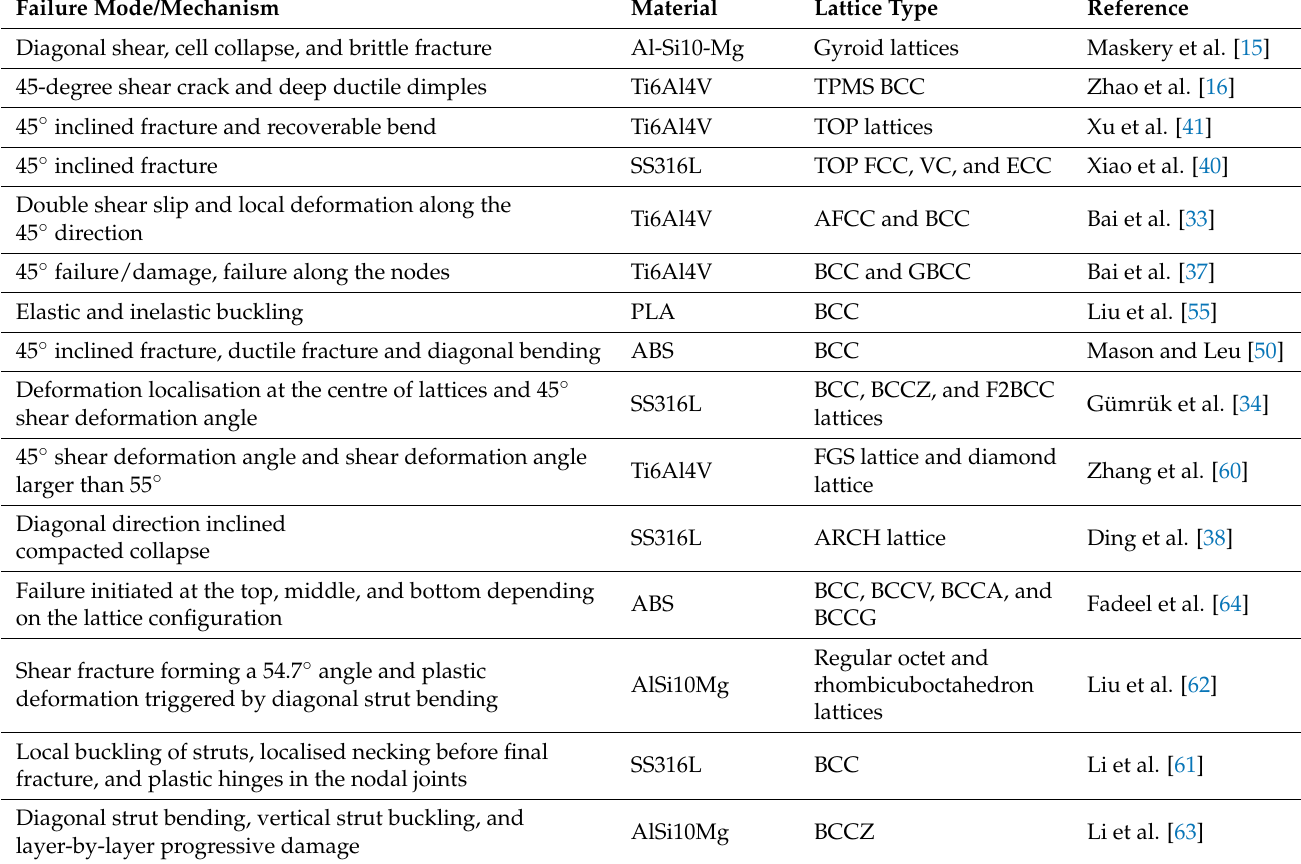
Table 2. Summary of reviewed studies on compressive failure